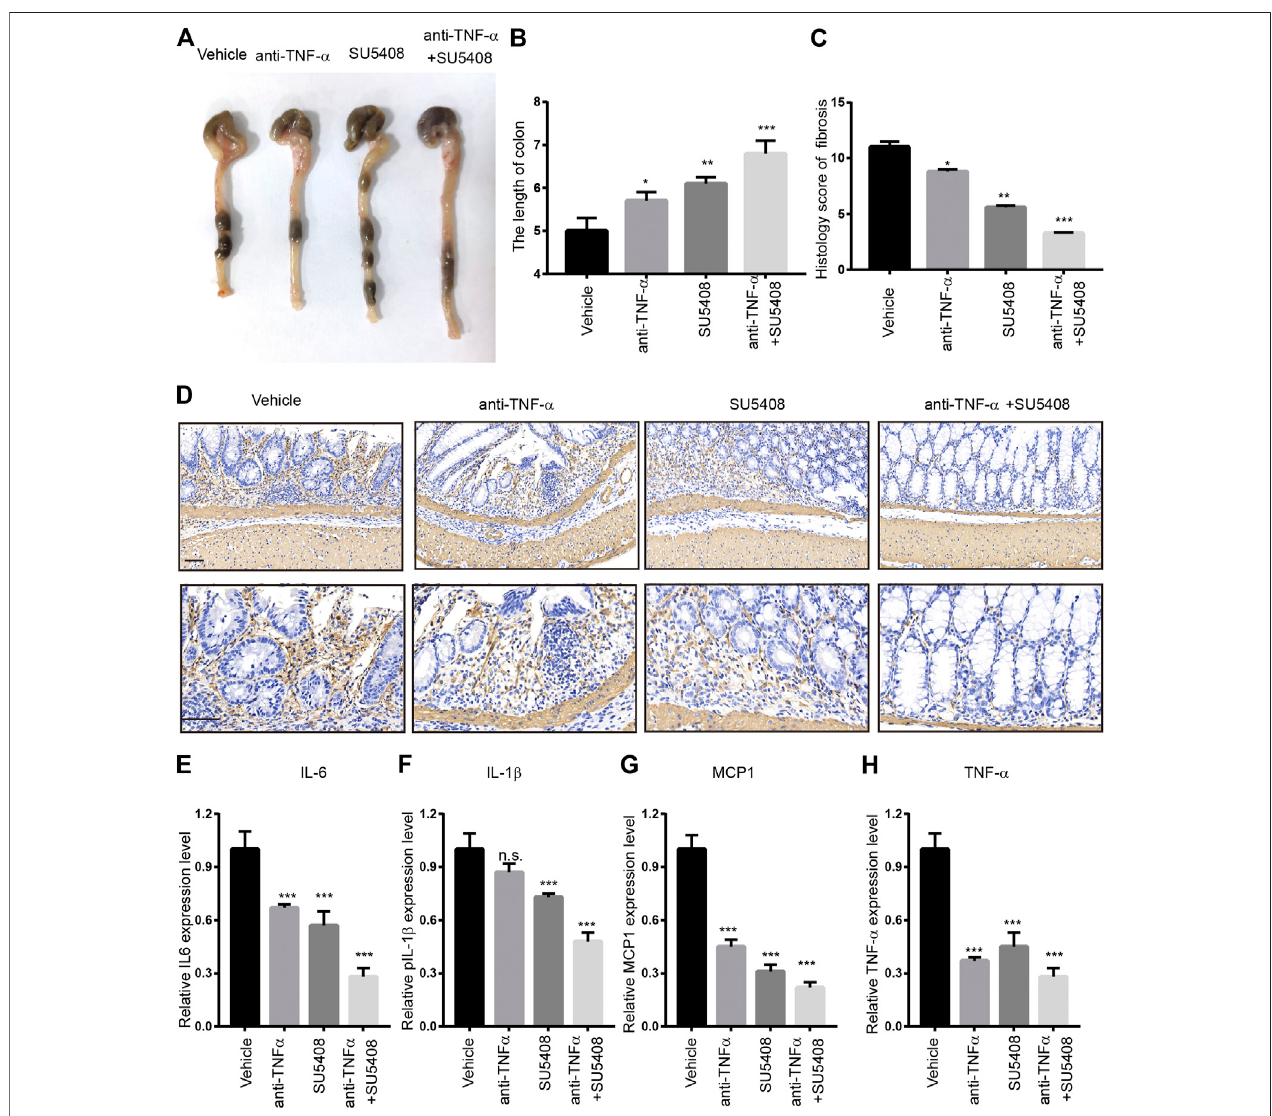
FIGURE6| Gremlin1-VEGFR2axisdisruptionimpededtheprogressionofintestinal fi brosis. (A) .Theappearanceofthecolonsfromthemicewithintestinal fi brosis treated with vehicle, anti-TNF- α monotherapy (100 μ g), SU5408 (5 mg/kg), or anti-TNF- α therapy combined with SU5408 treatment. (B) . The statistical results of colon length in mice with vehicle, anti-TNF- α monotherapy (100 μ g), SU5408 (5 mg/kg), or anti-TNF- α therapy combined with SU5408 treatment ( n (cid:1) 5). (C) . The histology score of intestinal fi brosis mice with different treatment. Fibrosis was quanti fi ed using a combined score of fi brosis severity, circularity and the extent of fi brosis ( n (cid:1) 5). (D) . α -SMAIHCstainingofintestinalsectionsfromintestinal fi brosismicewithdifferenttreatment.scalebar100 μ m (E – H) .TheproteinexpressionlevelofIL-6,IL- 1 β , MCP1, and TNF- α in the colon of different group mice treated with vehicle, anti-TNF- α monotherapy (100 μ g), SU5408 (5 mg/kg), or anti-TNF- α therapy combined withSU5408treatment( n (cid:1) 5). p valuesarederivedfromone-wayANOVAanalysis.Dunnett ’ stestwasusedtoanalysisthedifferencebetweencontrolgrouptotheother groups. n. s., p > 0.05; * p ≤ 0.05; ** p ≤ 0.01; *** p ≤ 0.001.